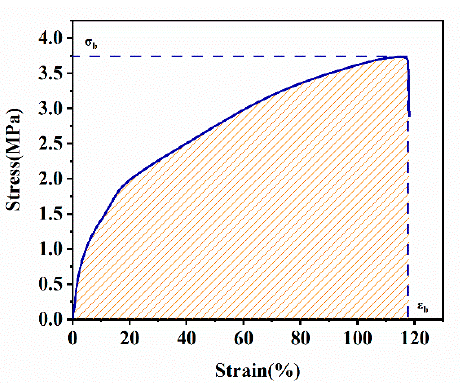
Figure 6. Stress-strain curve of the EPDM rubber composite under planar tension.